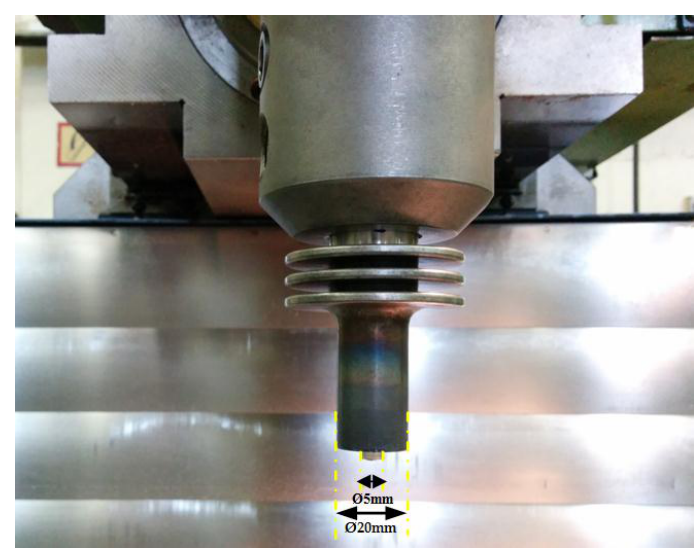
Figure 2. The tool used for FSW.